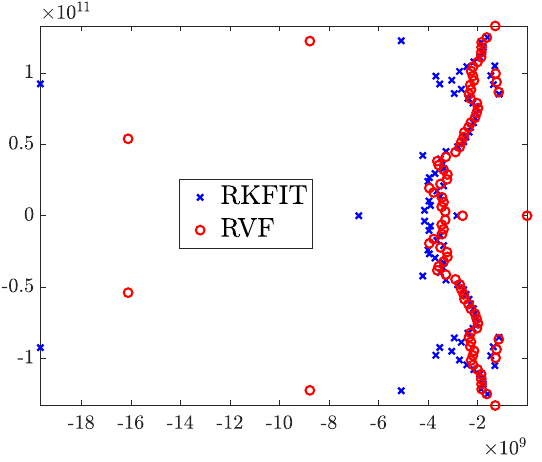
Figure 5. RKFIT and RVF poles.